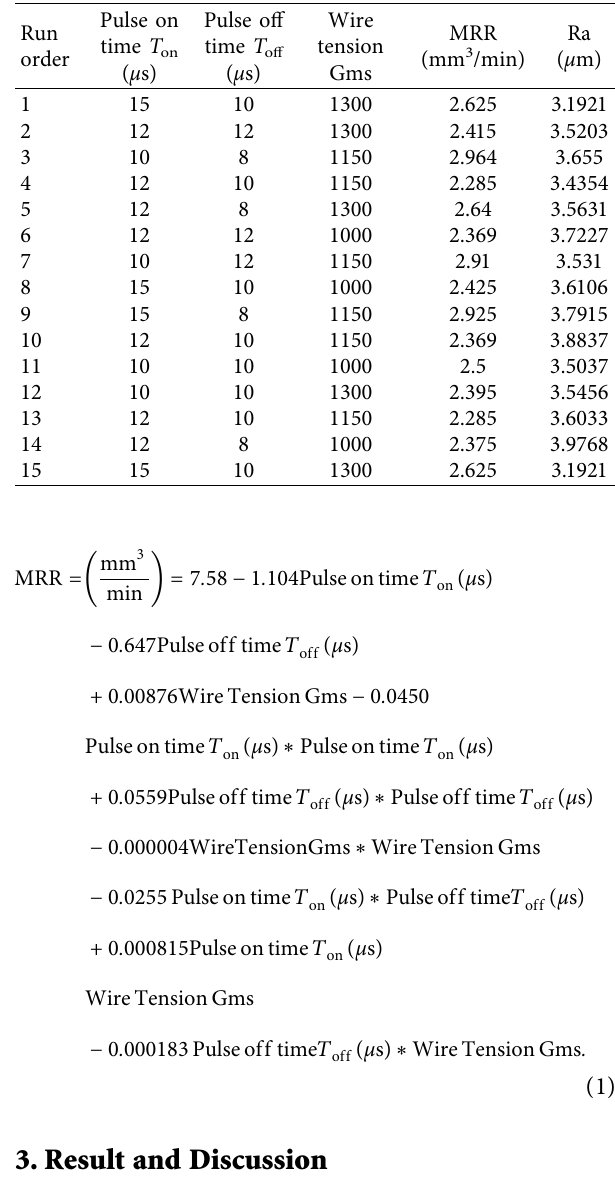
Table 2: Parameters and their